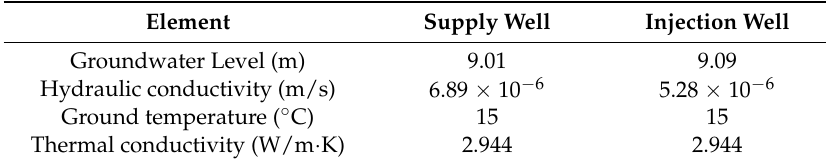
Figure 8. Simulation model. Table 6. Ground conditions of numerical analysis